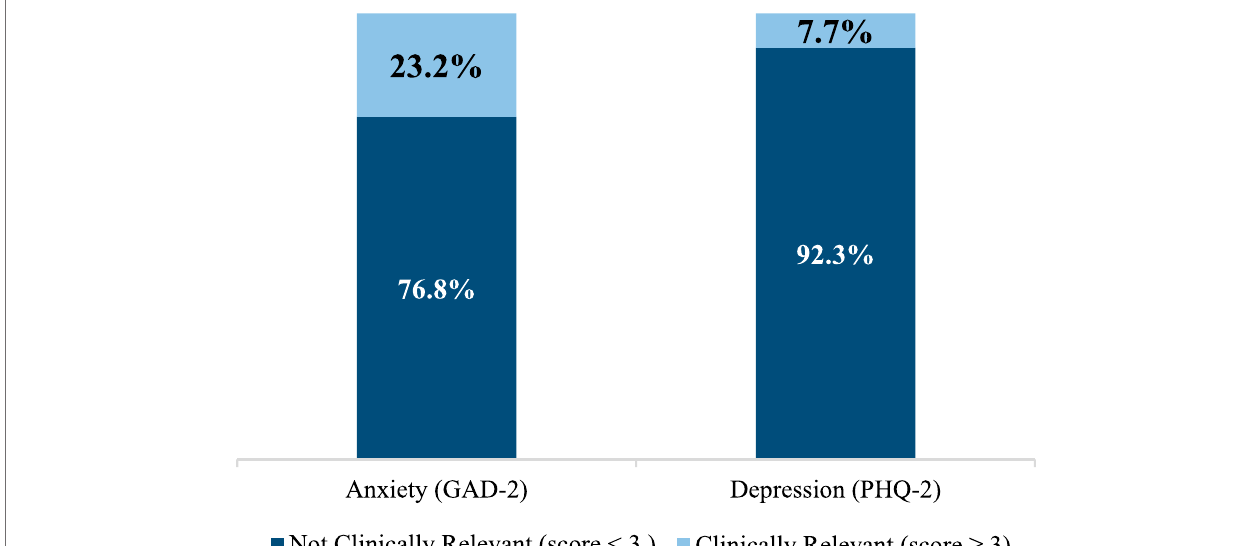
FIGURE 3 | Anxiety and Depression in School Mental Health Professionals Based on GAD-2 and PHQ-2 Scores. Note : N (cid:1) 155;Noresponses (cid:1) 7.SMHPsscreenforGeneralizedAnxietyDisorderifGAD-2scoreishigherthanorequalto3(Cronbach ’ s α (cid:1) 0.80).SPsscreenforMajor Depressive Disorder if PHQ-2 score is higher than or equal to 3 (Cronbach ’ s α (cid:1)